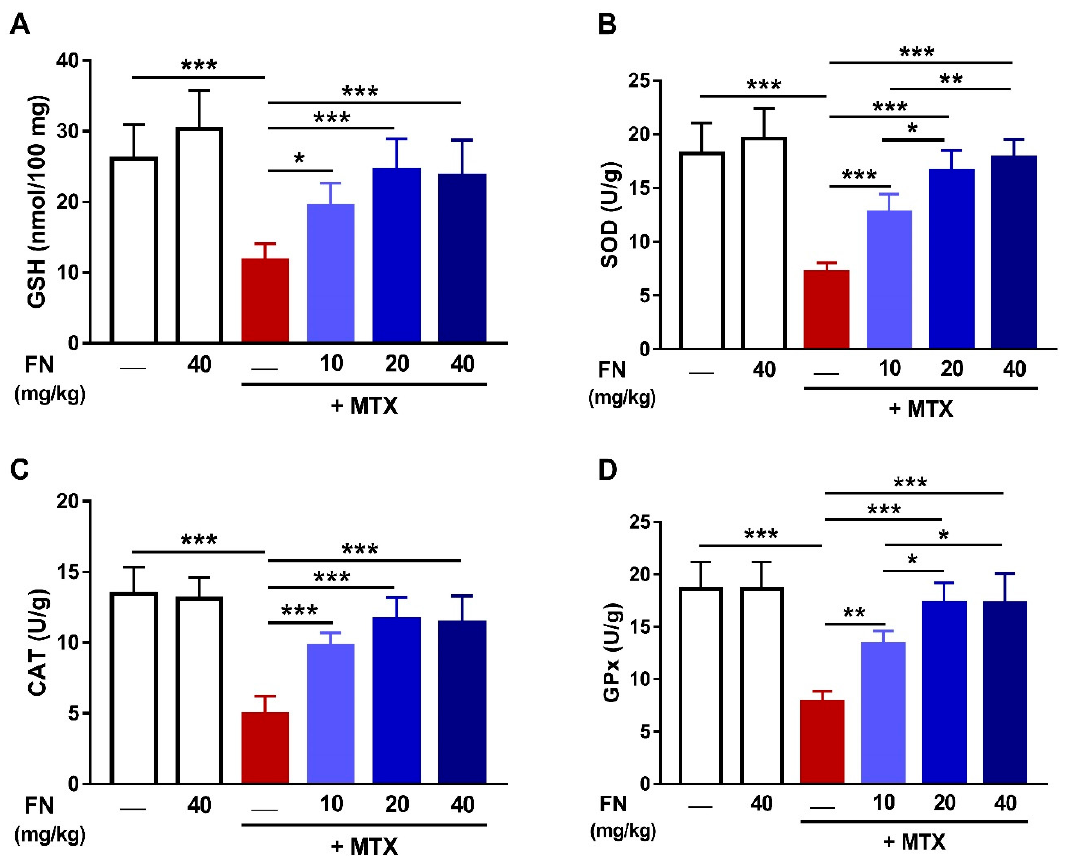
Figure 3. FN enhances antioxidants in the kidney of MTX-administered rats. FN increased renal glutathione (GSH) ( A ), superoxide dismutase (SOD) ( B ), catalase (CAT) ( C ), and glutathione peroxidase (GPx) ( D ) in MTX-induced rats. Data are mean ± SEM, ( n = 6). * p < 0.05, ** p < 0.01 and *** p < 0.001.